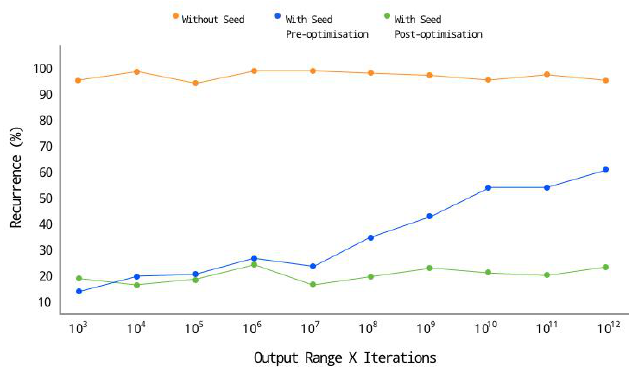
Fig. 23. Performance of three models low noise scenario I